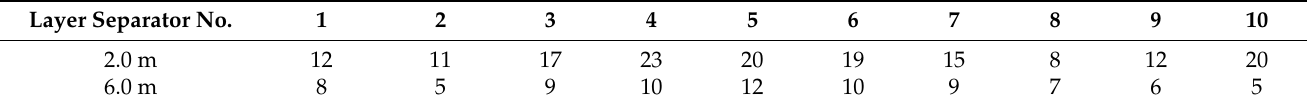
Table 7. Maximum Roof Separation (Unit: mm).